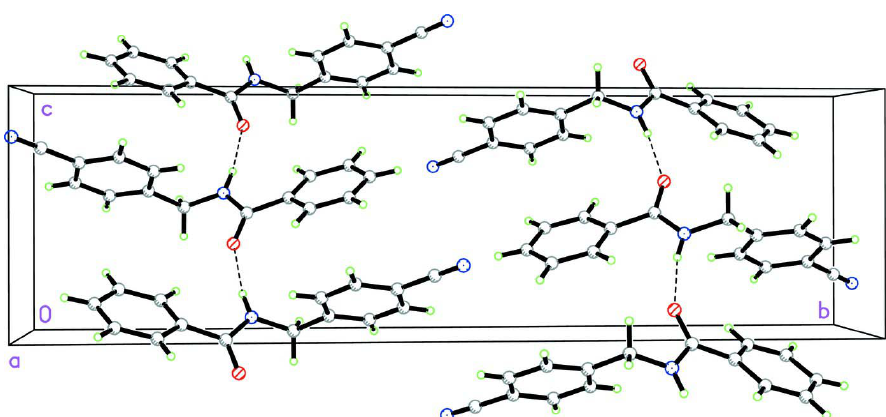
Figure 2 Packing diagram of (I). Hydrogen bonds are shown as dashed